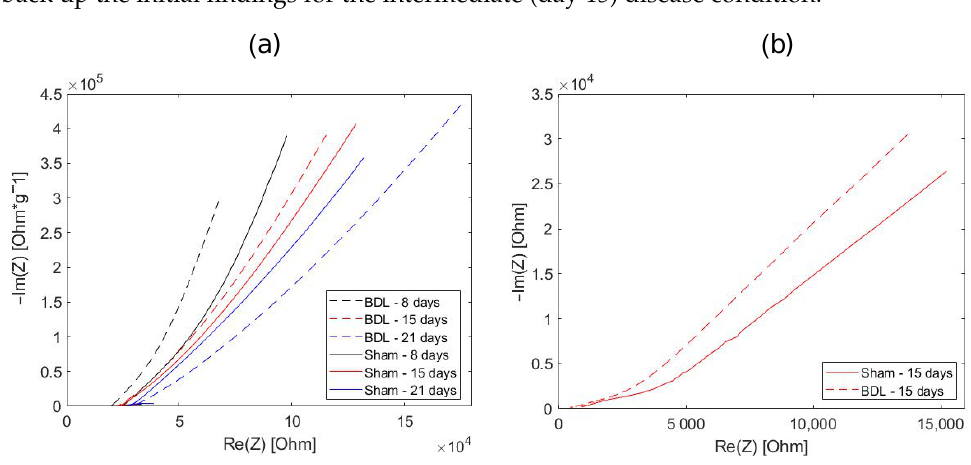
Figure A3. Nyquist plot of sham-operated and BDL ( a ) with the culture chamber setup and after mass normalization of the magnitude ( b ) through needle